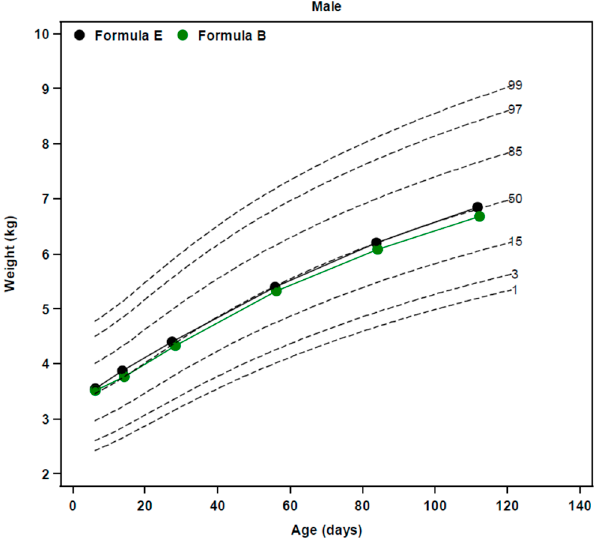
Figure 3. Mean WHO weight-for-age percentiles of evaluable healthy term male infants fed EHF-B and AAF-E to 4 months of age. Data source was from unpublished data from the study of Borschel et al. [14].